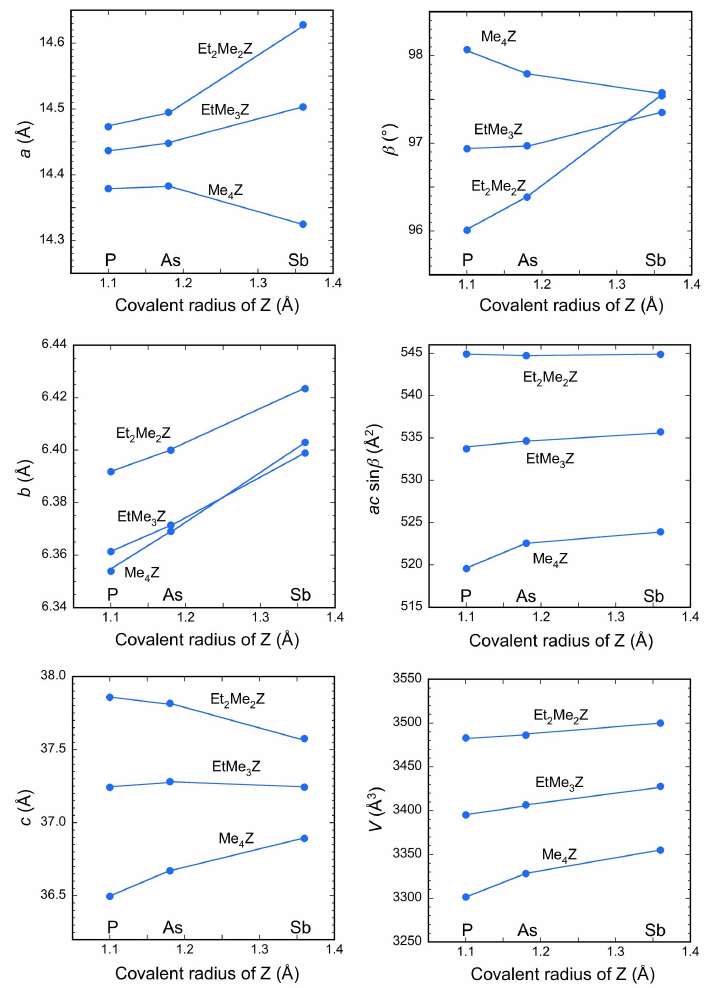
Z )[Pd(dmit) Me ] plotted as a function of the x 4−x 2 2 Z